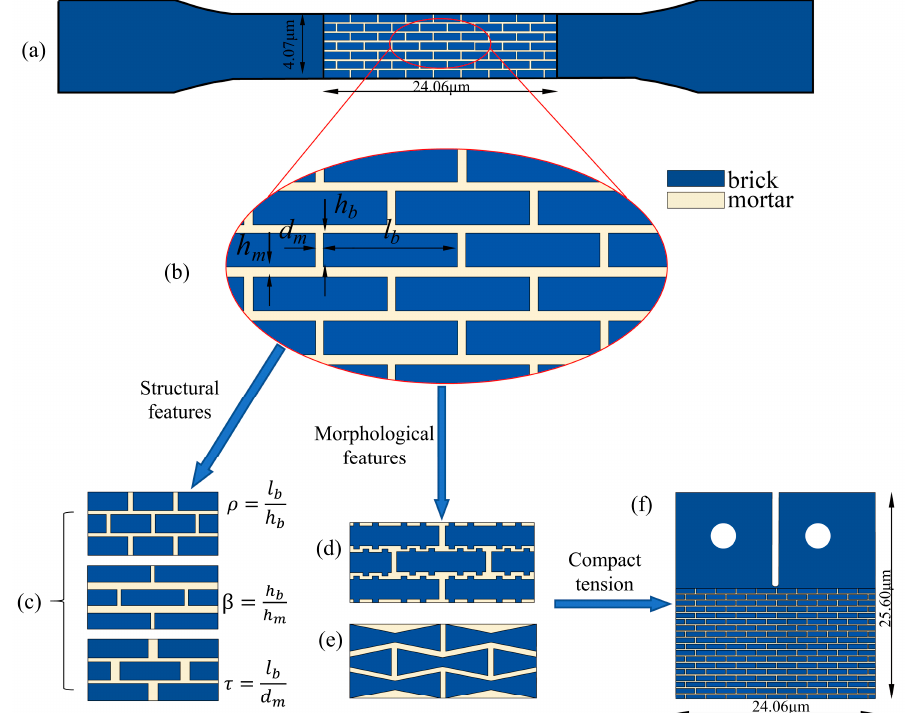
Figure 2. Schematic diagram of nacre model: ( a ) tensile test model, ( b )regular structure, ( c ) three structural parameters, ( d ) racked morphology, ( e ) wedged morphology, ( f ) c ‐ t model.